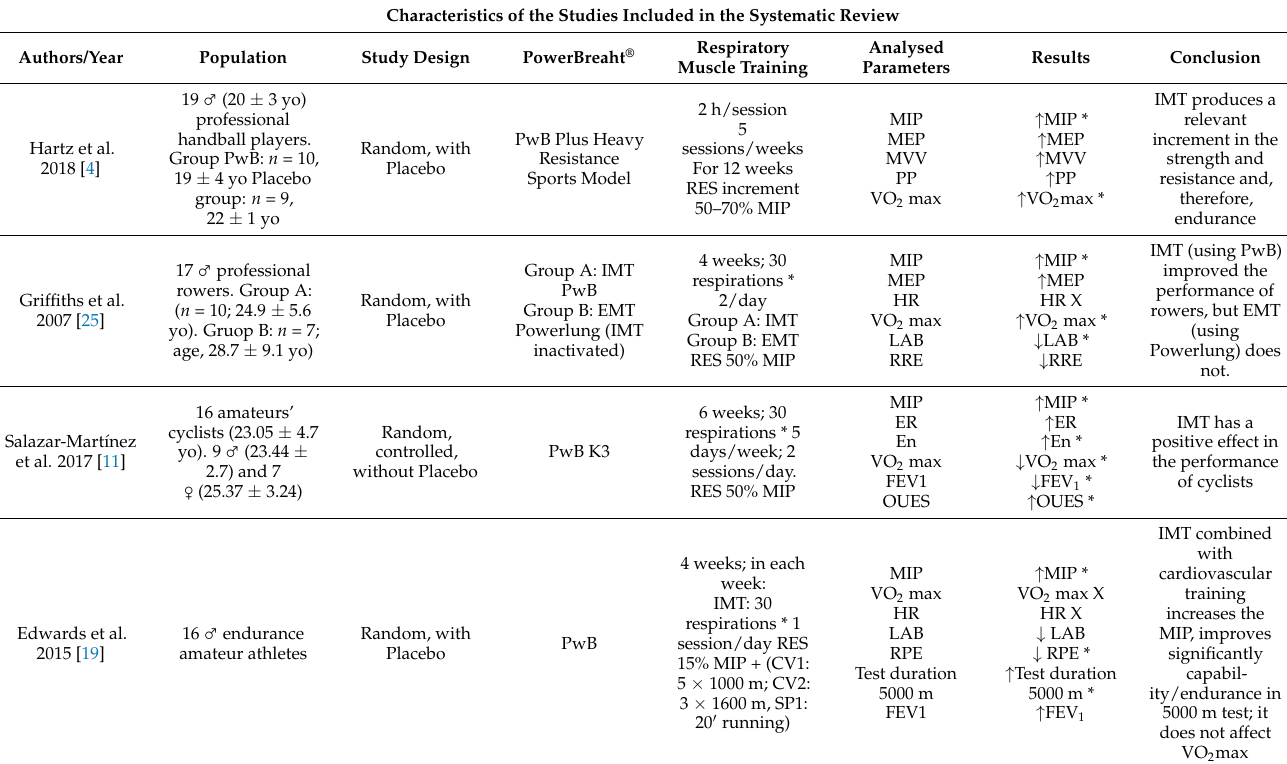
Table 3. Summary of the results of the studies included in the systematic